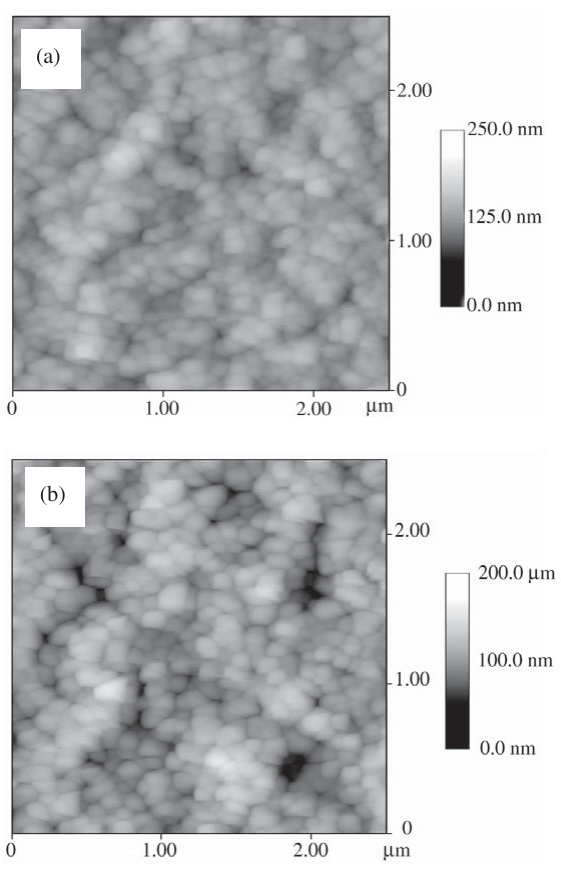
Figure 2. Surface morphology of PZT films obtained at 700 °C for: a) 5 min; b) 10 min.